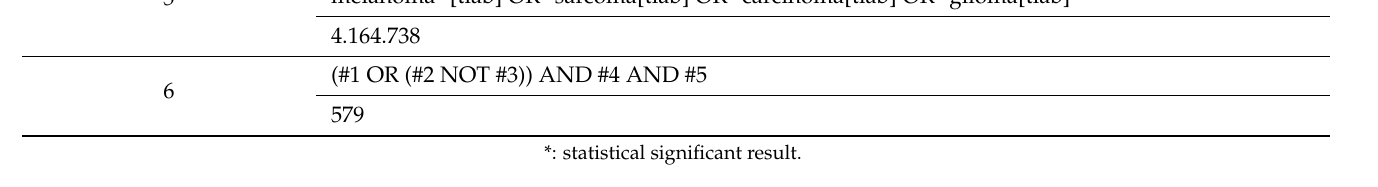
Table A2. Embase search